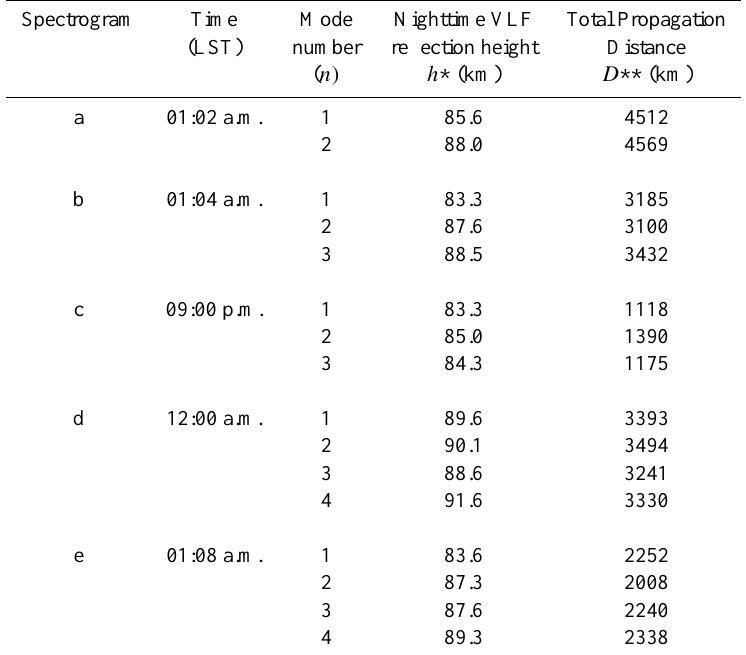
Fig.3. Variation of mean cut-off frequency, f cm , (solid line) and mean fundamental frequency, f cm / n , (dashed line) with mode number, n . The error bars indicate standard error in the estimated frequency. The numbers in parentheses indicate the total number of tweeks analyzed.